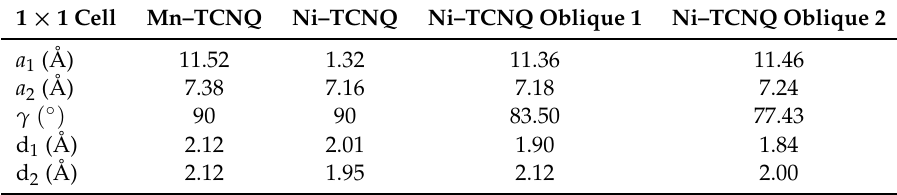
Table 1. Moduli of lattice vectors ( a 1 and a 2 ), angle between lattice vectors ( γ ), and bond lengths (d 1 and d 2 ) of the optimized Mn–TCNQ and Ni–TCNQ 1 × 1 rectangular and distorted unit